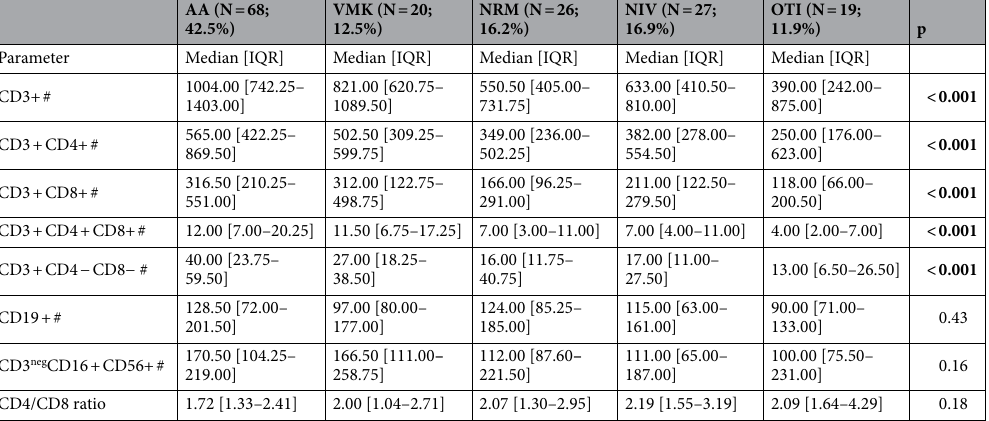
Table 3. T-, B- and NK-lymphocyte subpopulation absolute counts at baseline after patient stratification according to maximal oxygen supply/ventilation support. Statistically significant p values are highlited in bold. Reference values: CD3+ (cells/µl): 690–2540; CD3 + CD4+ (cells/µl): 410–1590; CD3 + CD8+ (cells/µl): 190– 1140; CD19 + (cells/µl): 90–660; CD3 neg CD16 + CD56+ (cells/µl): 90–590; CD4/CD8 ratio: 1.5–2.5